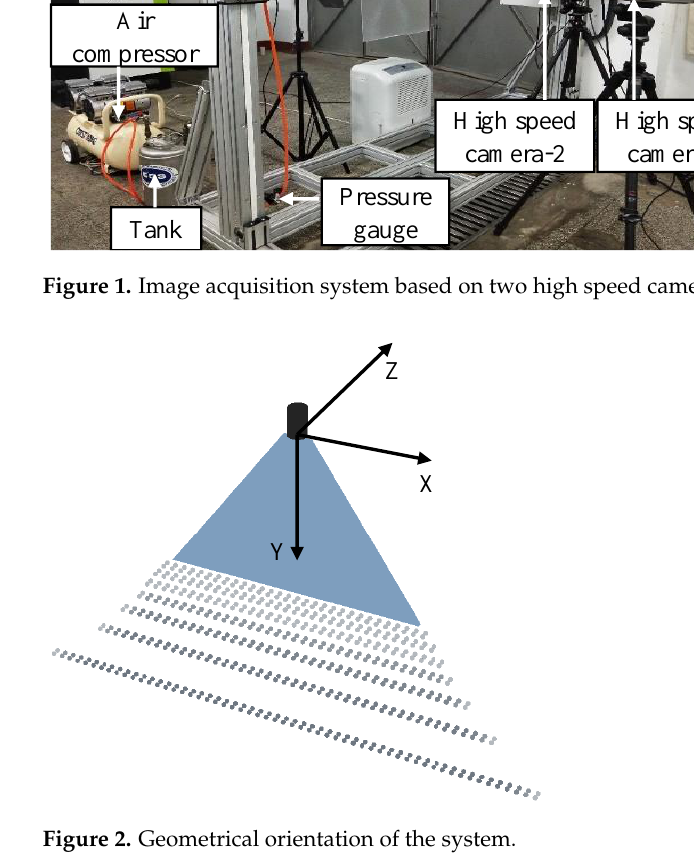
Figure 2. Geometrical orientation of the system.